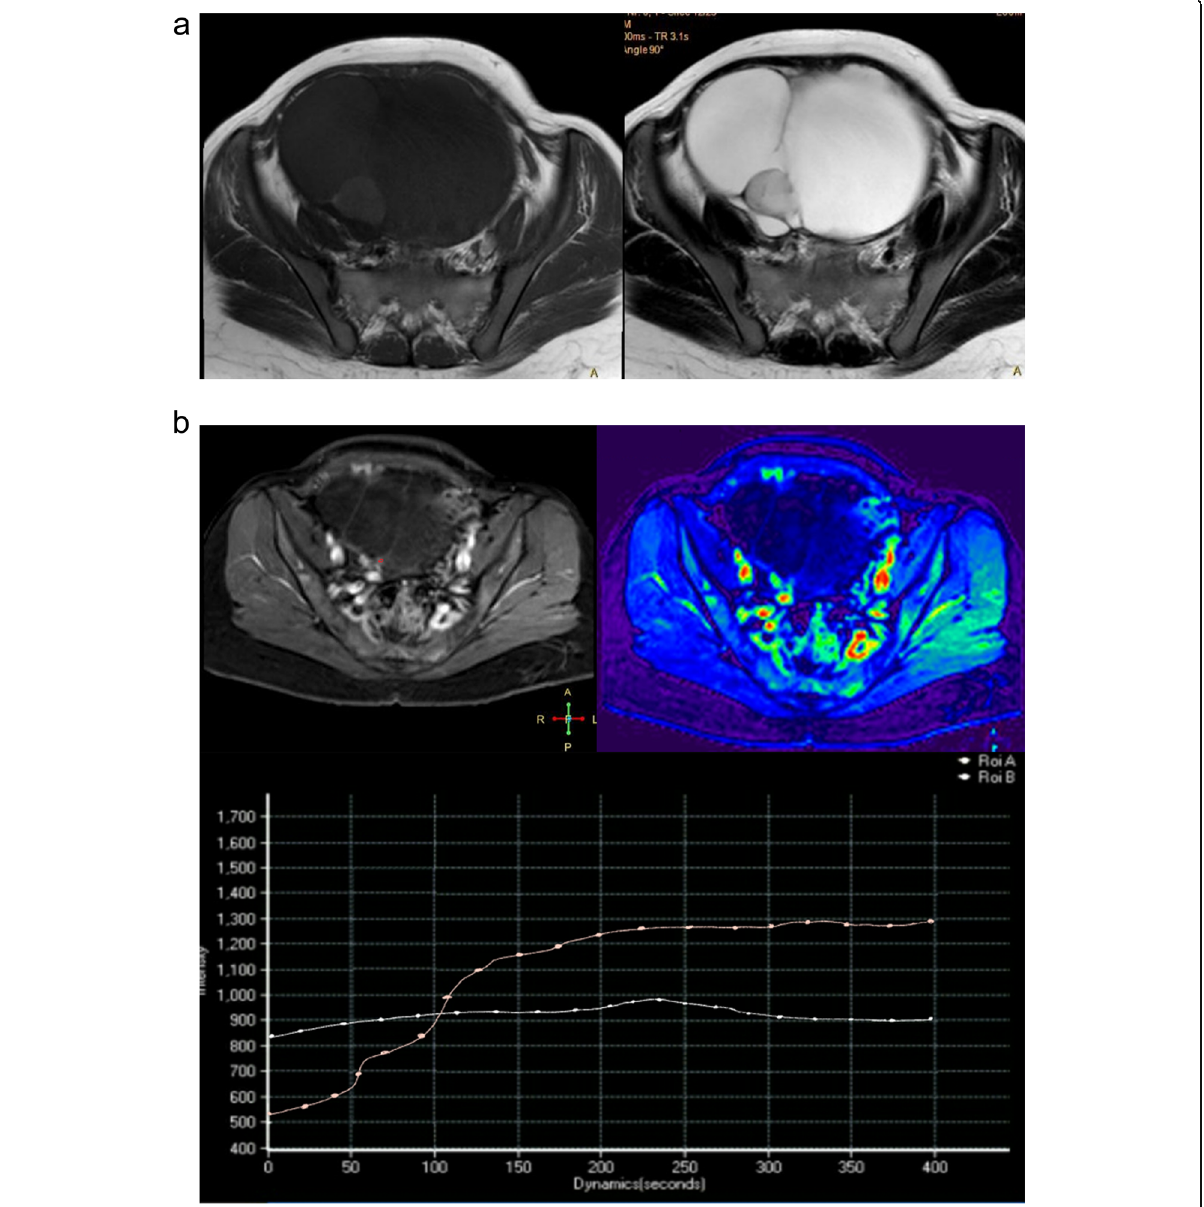
Fig. 3 A 45-year-old female presented with pelvic pain and pelvi-abdominal swelling. The patient underwent hysterectomy 5 years ago. US revealed a large complex right adnexal cystic mass with solid components. Axial T1 and T2 predominantly cystic right adnexal lesion with solid components within. Ascites and peritoneal deposits are seen. MR perfusion shows early intense increasing enhancement type 3 curve. Color map shows the areas of maximum enhancement. Final histopathological granulosa cell